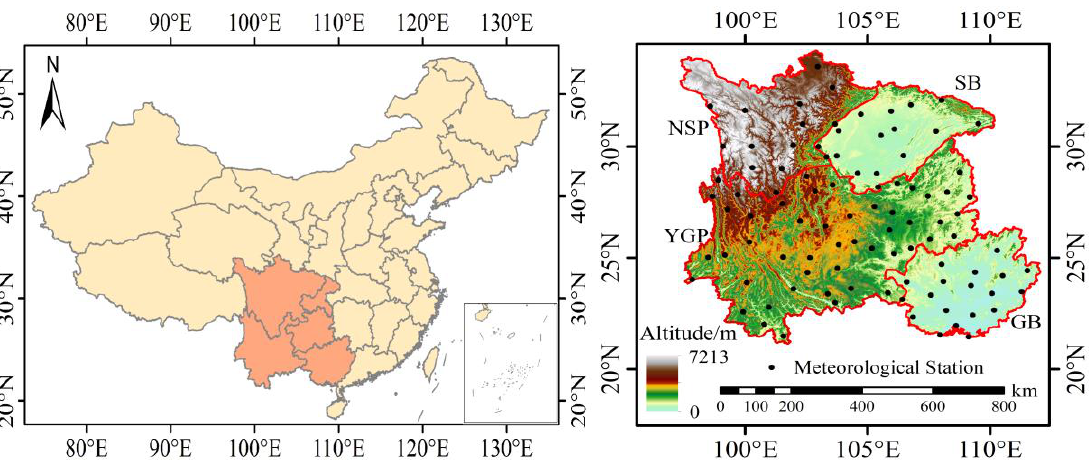
Figure 1. Map of weather stations distribution of 4 regions in Southwest China. NSP: Northwest Sichuan Plateau; SB: Sichuan Basin; YGP: Yunnan–Guizhou Plateau; GB: Guangxi Basin.